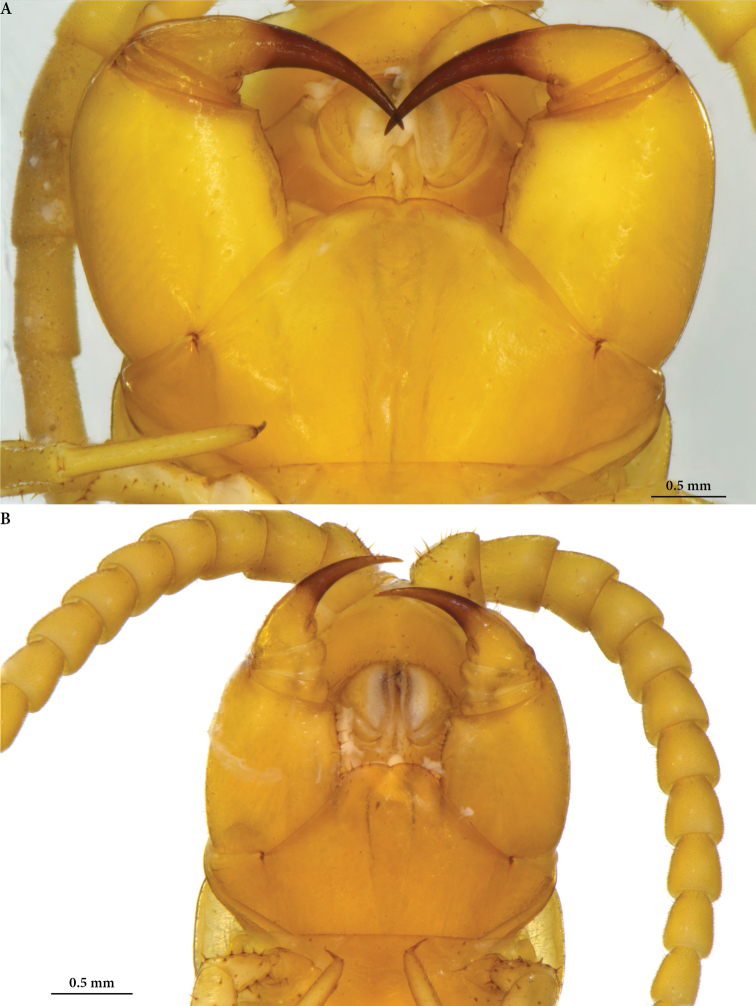
Cryptops spp., forcipular coxosternum, ventral view ACryptops
speleorex sp. nov., holotype BCryptops
anomalans, Pirin Mts (Bulgaria).